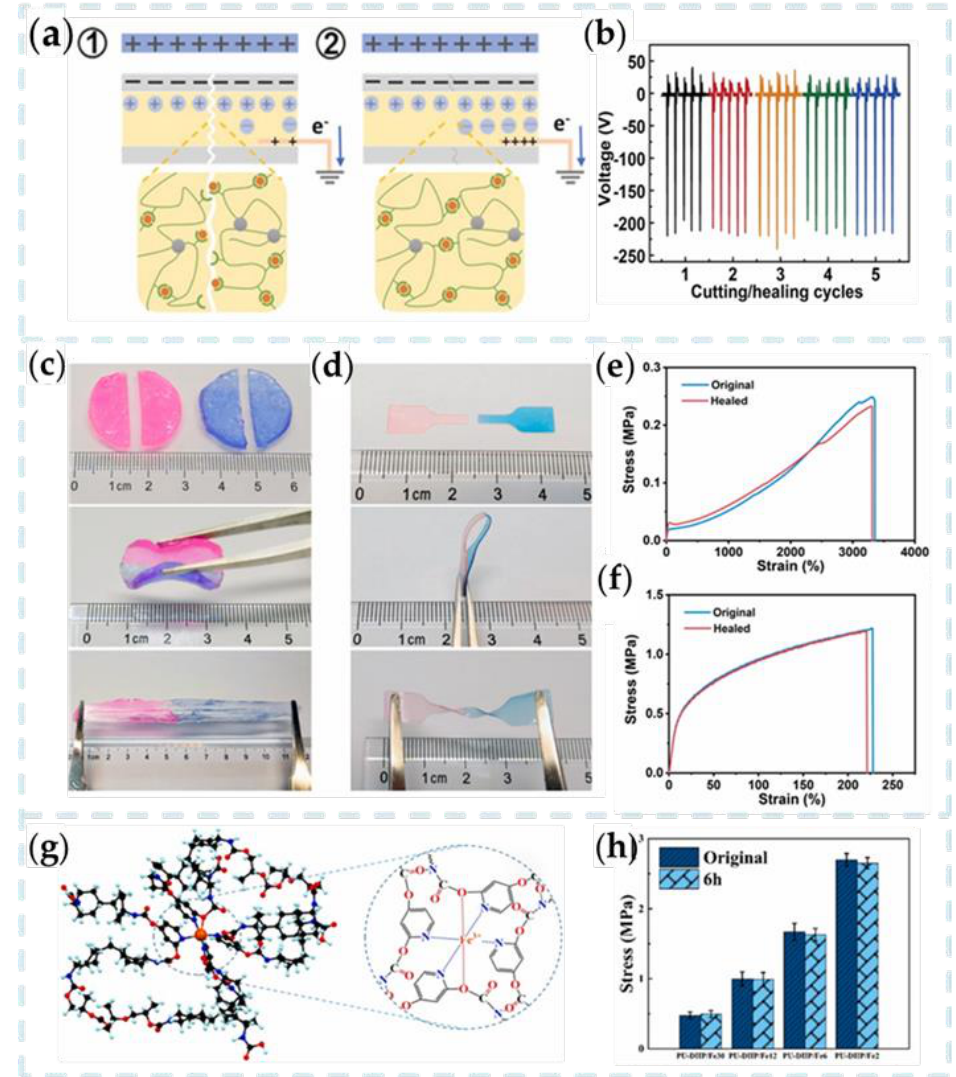
Figure 8. ( a ) Schematic diagram showing (1) damage to the output performance of the SI-TENG and (2) healing of the output performance of the SI-TENG. ( b ) The open-circuit voltage of the SI-TENG after different cutting/healing cycles [81]. Copyright 2022, WILEY-VCH VERLAG GMBH. Optical images of the self-healing process for ( c ) glycerol-based PAAM-Clay organohydrogel and ( d ) IU-PDMS. Stress–strain curves of ( e ) glycerol-based PAAM-Clay organohydrogel and ( f ) IU-PDMS before and after self-healing [82]. Copyright 2021, ELSEVIER. ( g ) Schematic diagram of coordination and hydrogen-bonded dual-dynamic network. ( h ) Comparison of self-healing efficiency of PU-DHP/Fe30, PU-DHP/Fe 12 , PU-DHP/Fe 6 and PU-DHP/Fe 2 [83]. Copyright 2021, ELSEVIER.